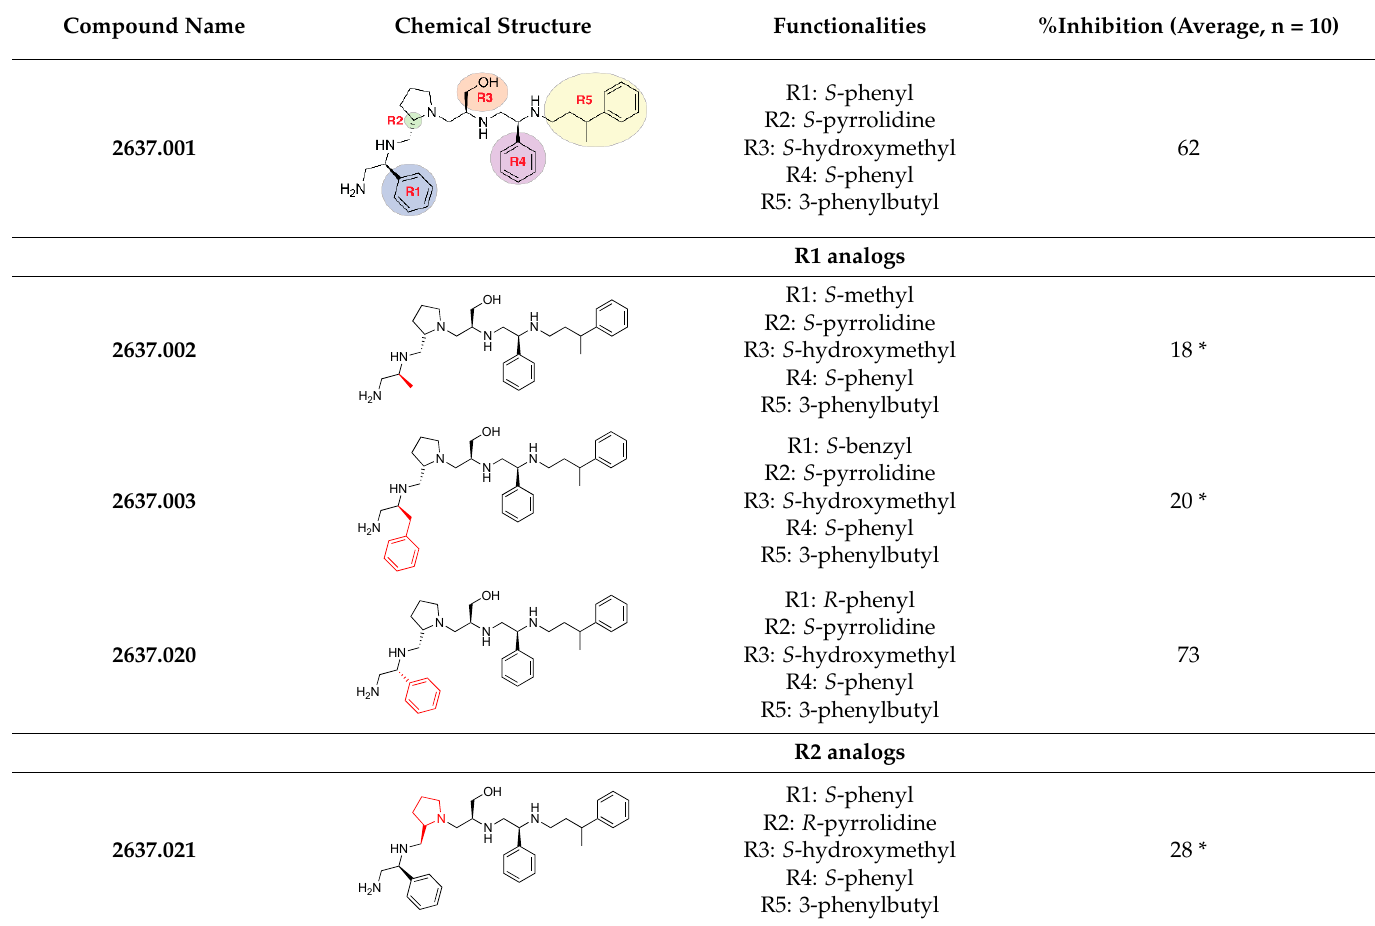
Table 1. Properties of 2637.001 analogs.